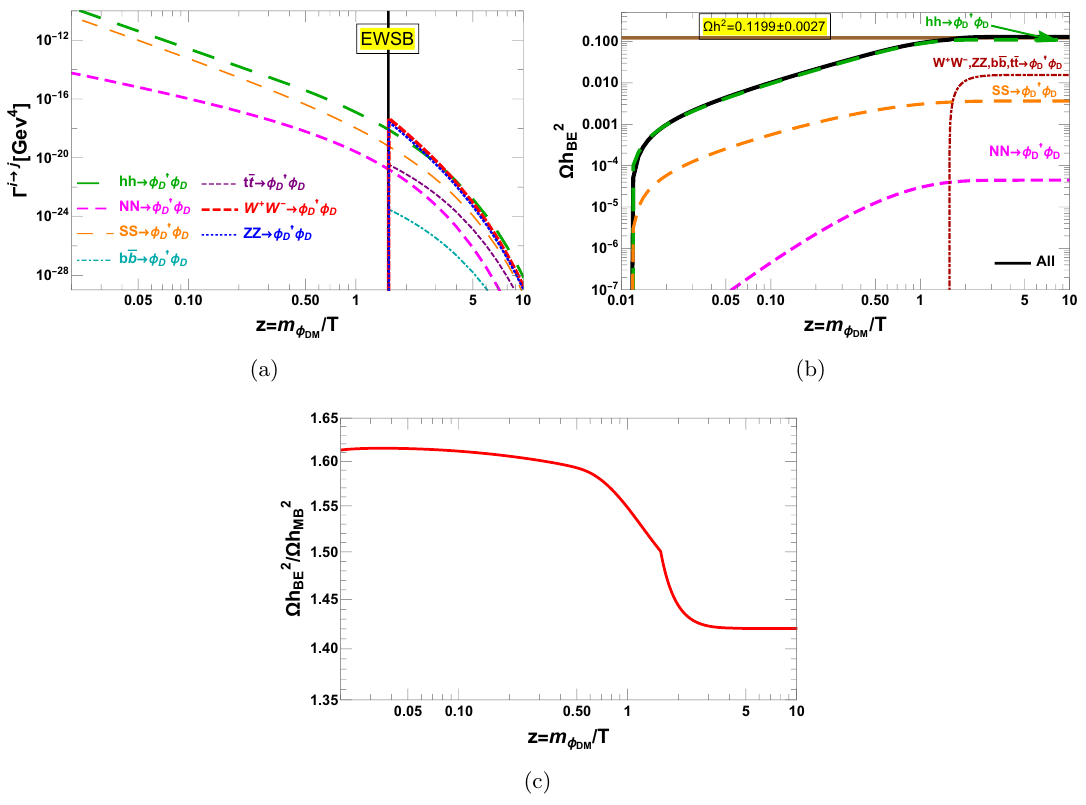
Figure 5 . The figures correspond to Scenario-1 . Figure 5(a) shows the relativistic reaction rates for the process hh → φ † φ D and other relevant processes. Figure 5(b) shows the individual contri- D butions to the relic density, and the total relic density. The brown horizontal line represents the present experimentally measured relic density [54]. Figure 5(c) shows the relative enhancement in the relic density with respect to Maxwell-Boltzmann